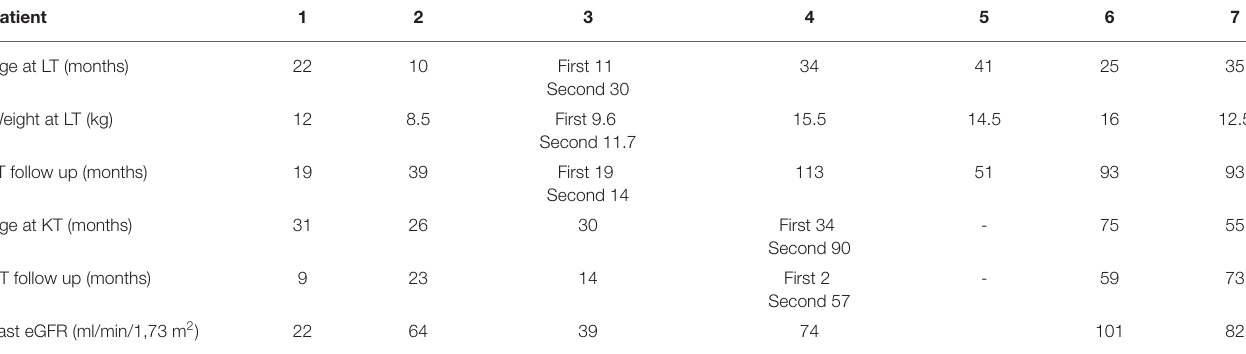
TABLE 3 | Liver and Kidney transplantations.